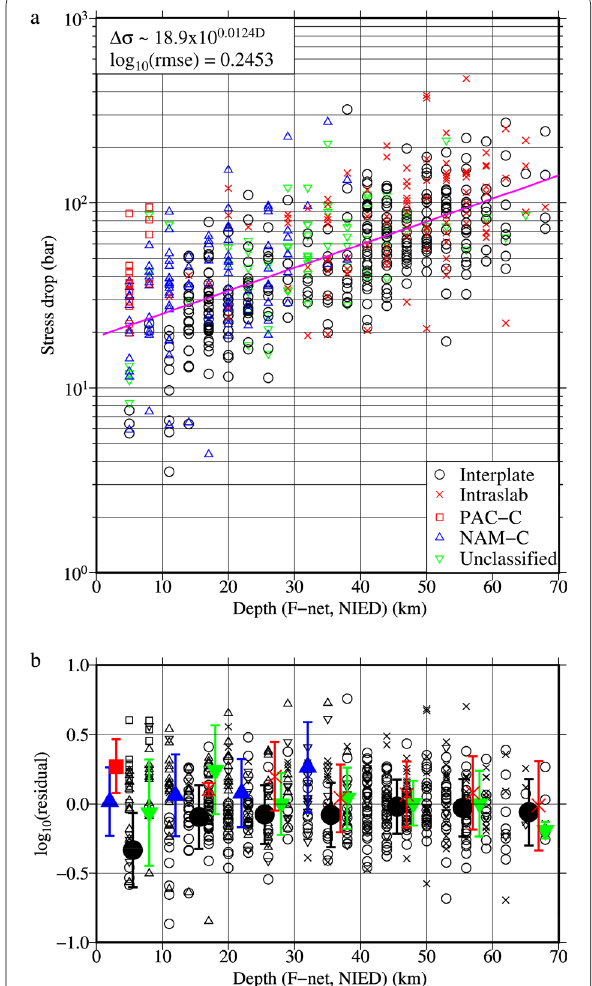
Fig. 6 a Plots of stress drop versus depth. The values for the different earthquake types are denoted by different symbols. The PAC-C (red squares) and NAM-C (blue triangles) in the legends denote the crustal earthquakes in the Pacific and North American Plates, respectively. The Unclassified (inverted triangles, green) means the earthquakes, V s r = 0.37 × whose tectonic types were not ascertained. b Plots of stress-drop (7) f c residuals against depth. The different symbols correspond to the different earthquake types as indicated in a above. The filled symbols denote the mean residuals for the corresponding earthquake types computed in the interval of 10 km and the vertical bars denote the range of one standard deviation. The mean residuals are shifted slightly in horizontal directions from the centers of the corresponding intervals for